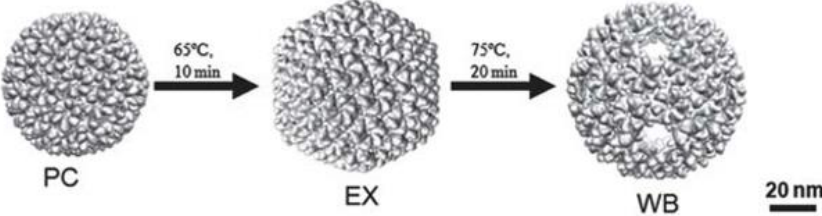
Figure 4. External view of the three P22 VLP morphologies and the process of transformation. Procapsid morphology (PC), 58 nm size and 2.5 nm pores; expanded shell morphology (EX), 65 nm size and 1.3 nm pores; and wiffleball morphology (WB), 65 nm size and 10 nm pores (adapted from [59]).